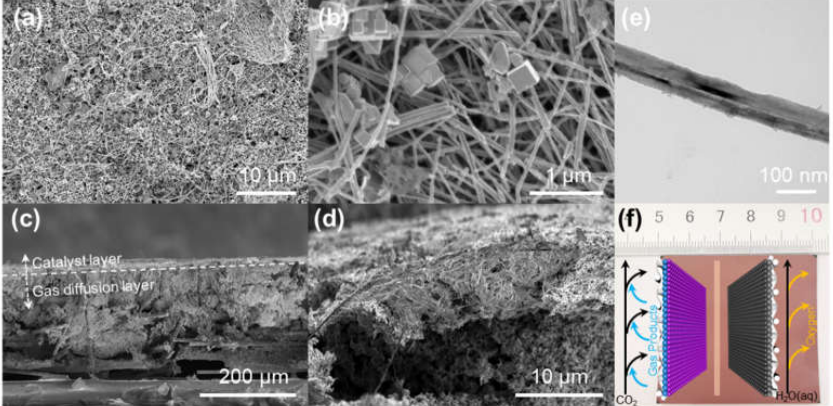
Figure 3. ( a , b ) SEM images and ( c , d ) cross-sectional SEM images of CuNW-based gas diffusion elec- trode; ( e ) TEM image of CuNWs; ( f ) photograph and schematic diagram of CuNW-based gas diffu- sion electrode.